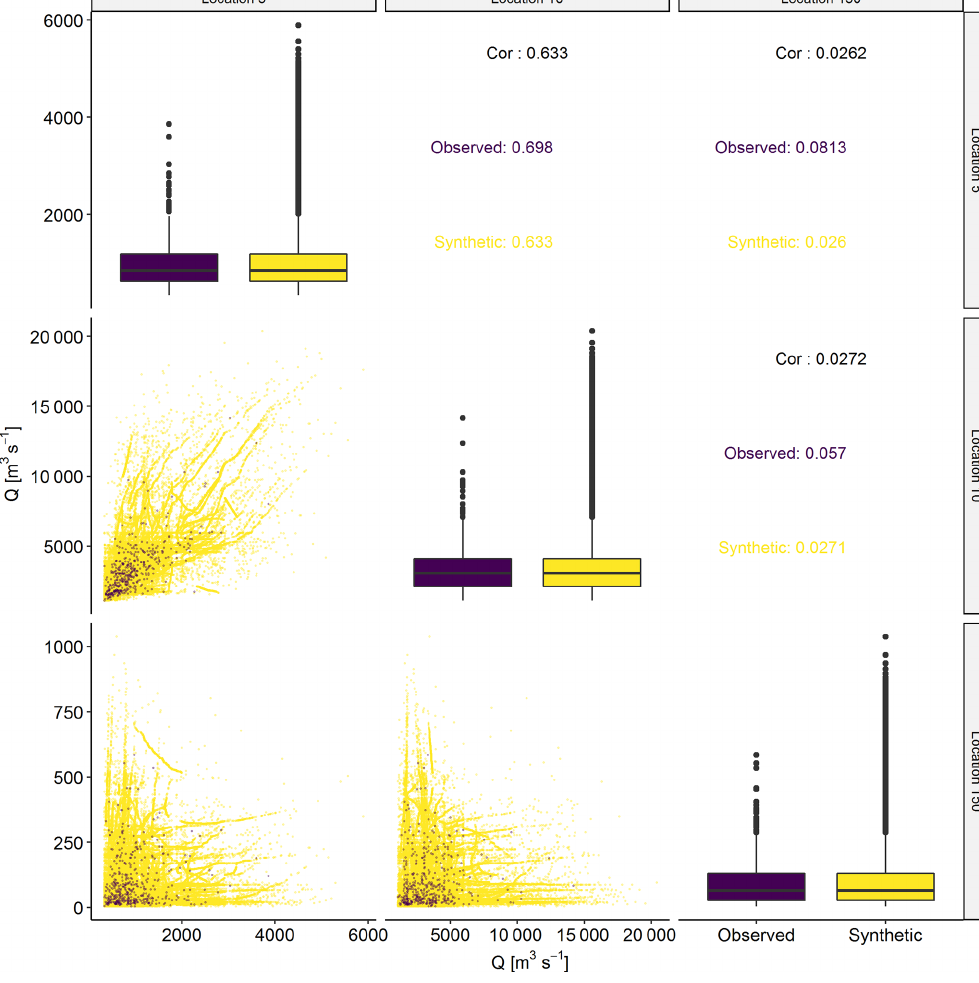
Figure 7. Observed (purple) vs. synthetic (yellow) descriptors at three locations. In the diagonal, distributions of observed and synthetic descriptors per location are compared using box plots. Below the diagonal, pairwise scatter plots are displayed. Above the diagonal, pairwise correlations are